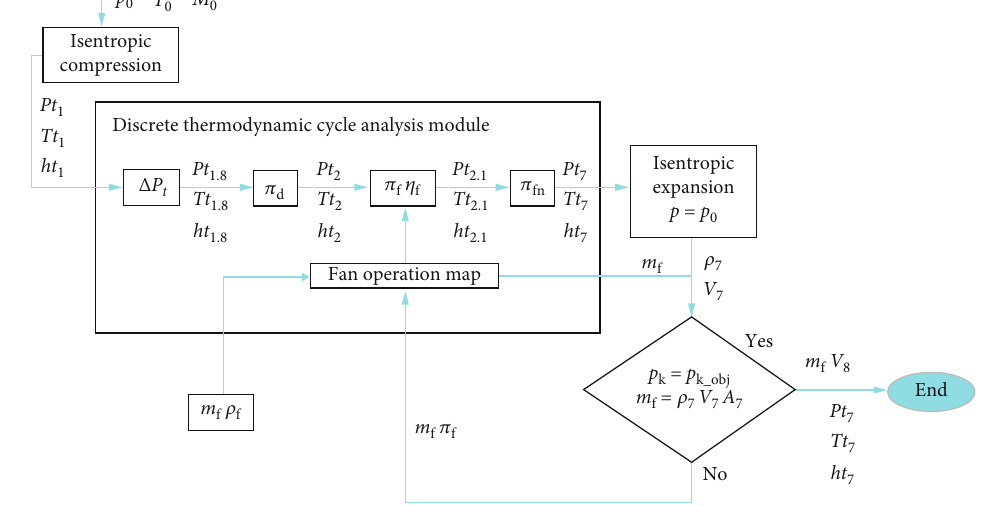
Figure 7: Component-based propulsor model.